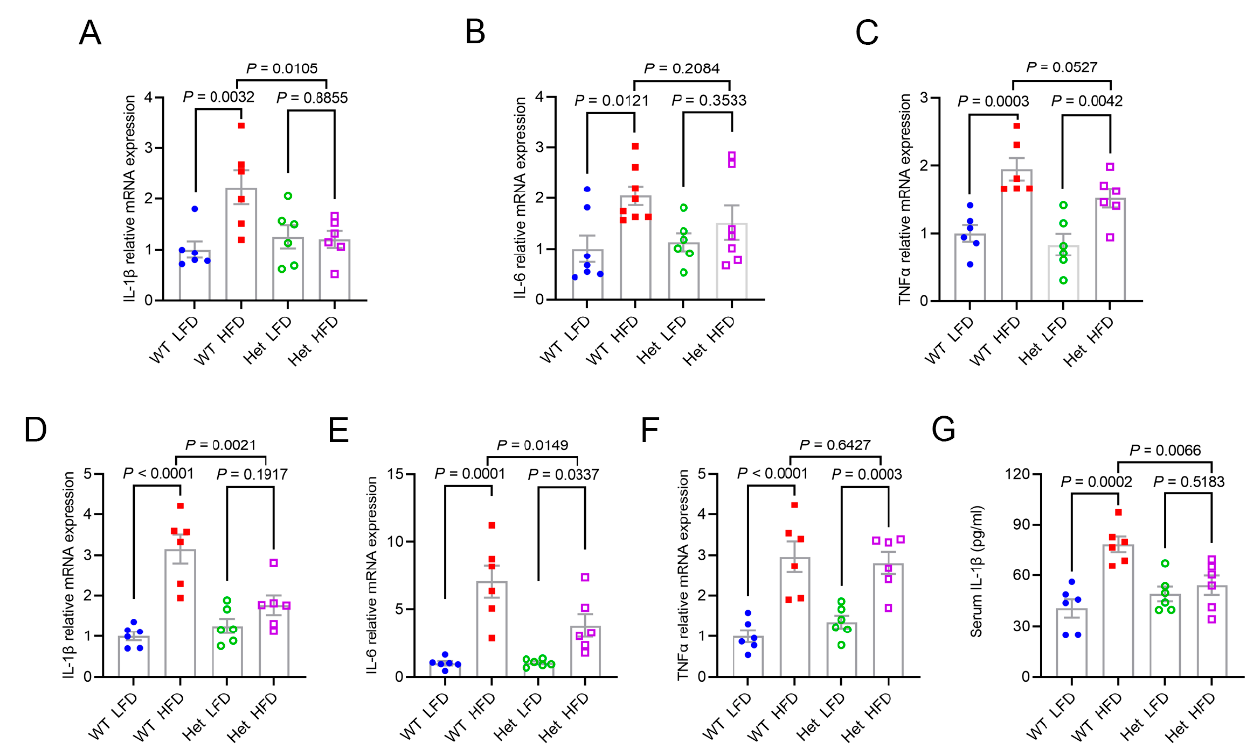
Figure 5. Mtfmt haploinsufficiency alleviates HFD-induced inflammation. ( A – C ) The relative ex- pression levels of IL-1 β ( A ), IL-6 ( B ), and TNF α ( C ) mRNA in the livers of WT LFD, WT HFD, Het LFD, and Het HFD mice. ( D – F ) The relative expression levels of IL-1 β ( D ), IL-6 ( E ), and TNF α ( F ) mRNA in the epididymal fat of WT LFD, WT HFD, Het LFD, and Het HFD mice. ( G ) Blood IL-1 β concentrations in WT LFD, WT HFD, Het LFD, and Het HFD mice.